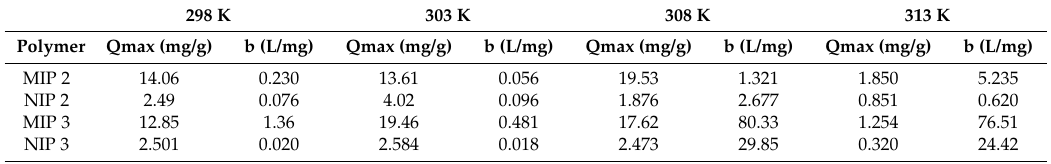
Table 4. Parameters of the Langmuir linearisation isotherms for the retention of BPA with MIPs and NIPs. 298 K 303 K 308 K 313 K Polymer Qmax (mg/g)